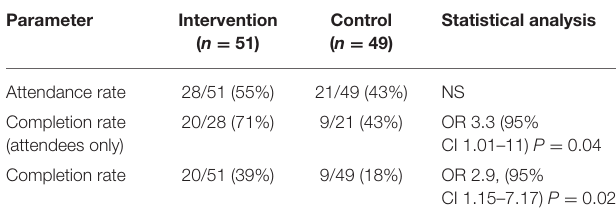
TABLE 3 | Heart failure outreach service referral rates among patients recruited to TeleClinical Care.